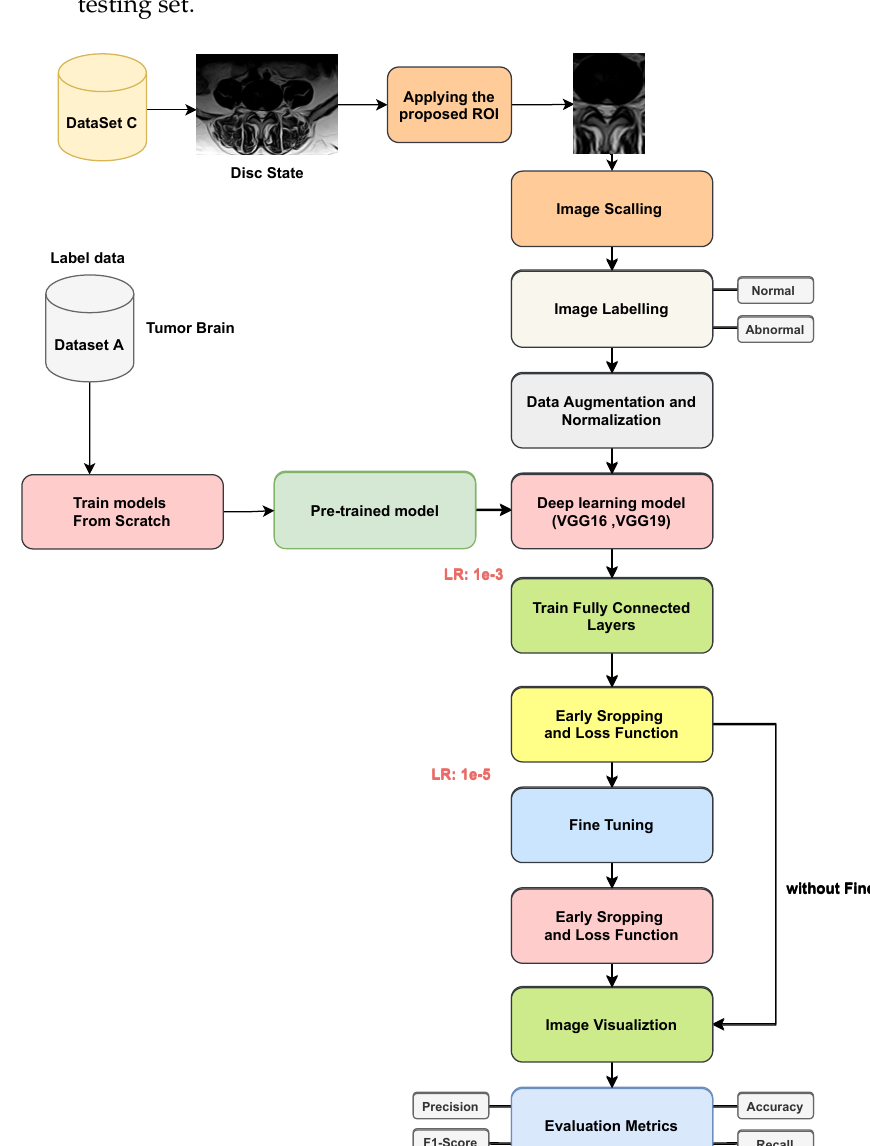
Figure 14. Transfer learning for disc state classification from labelled Dataset